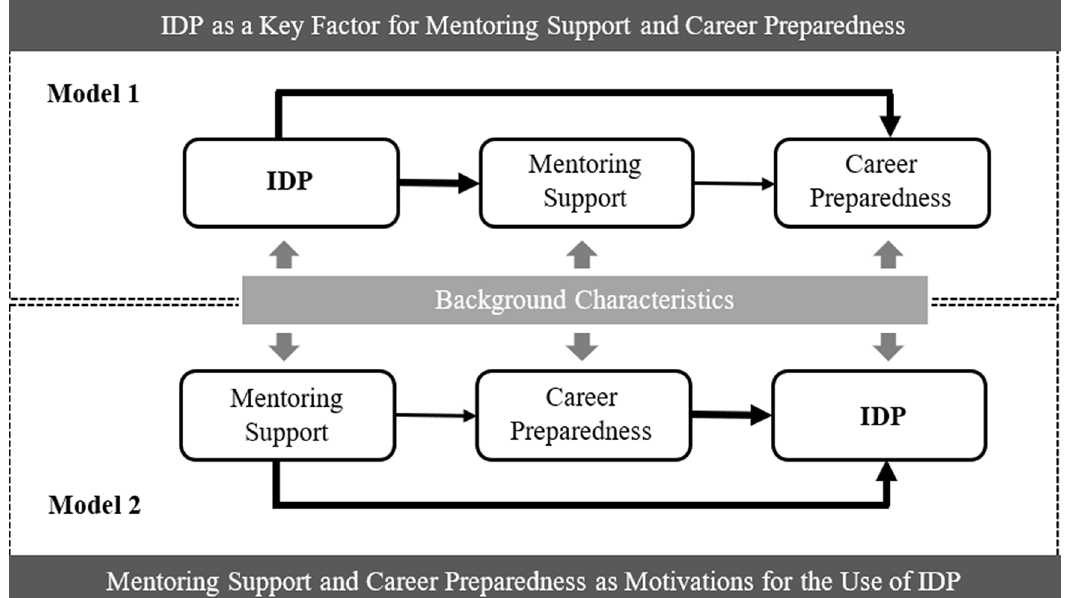
Figure 1. Conceptual models for the individual development plan (IDP), mentoring support, and career